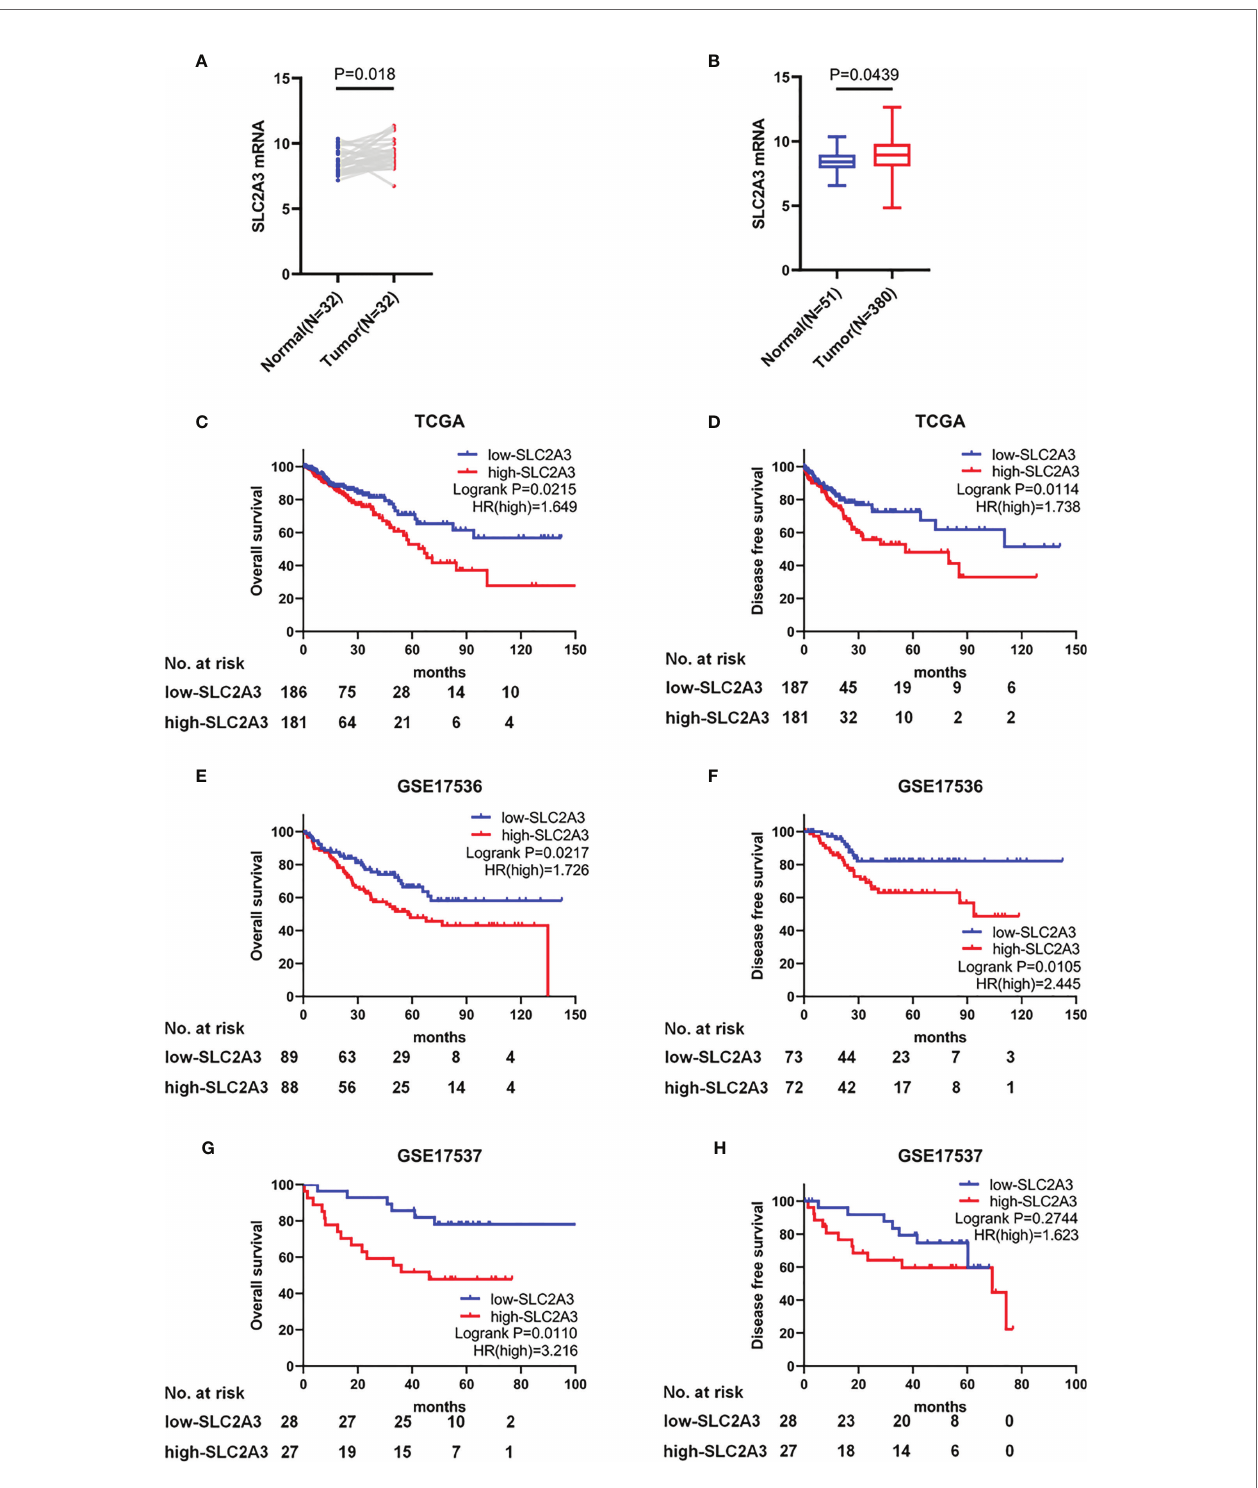
FIGURE 1 | SLC2A3 serves as an oncogenic role in CRC and high SLC2A3 expression predicts poor prognosis. (A) The expression of SLC2A3 in paired CRC samples from TCGA. (B) The expression of SLC2A3 in all CRC samples from TCGA. The correlation between SLC2A3 expression and survival status in (C, D) TCGA, (E, F) GSE17536, and (G, H)